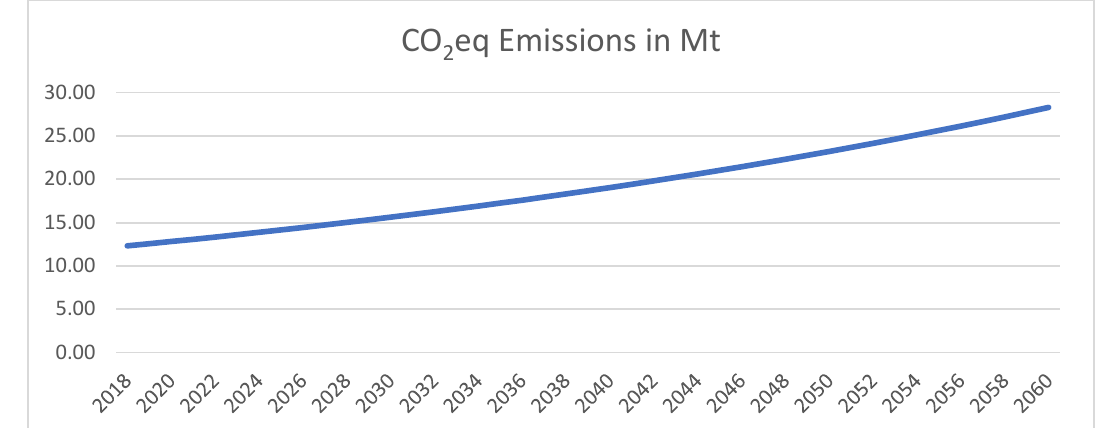
Figure 9. CO 2 eq emission forecast for the private sector of petrochemical (40% of all the producers).